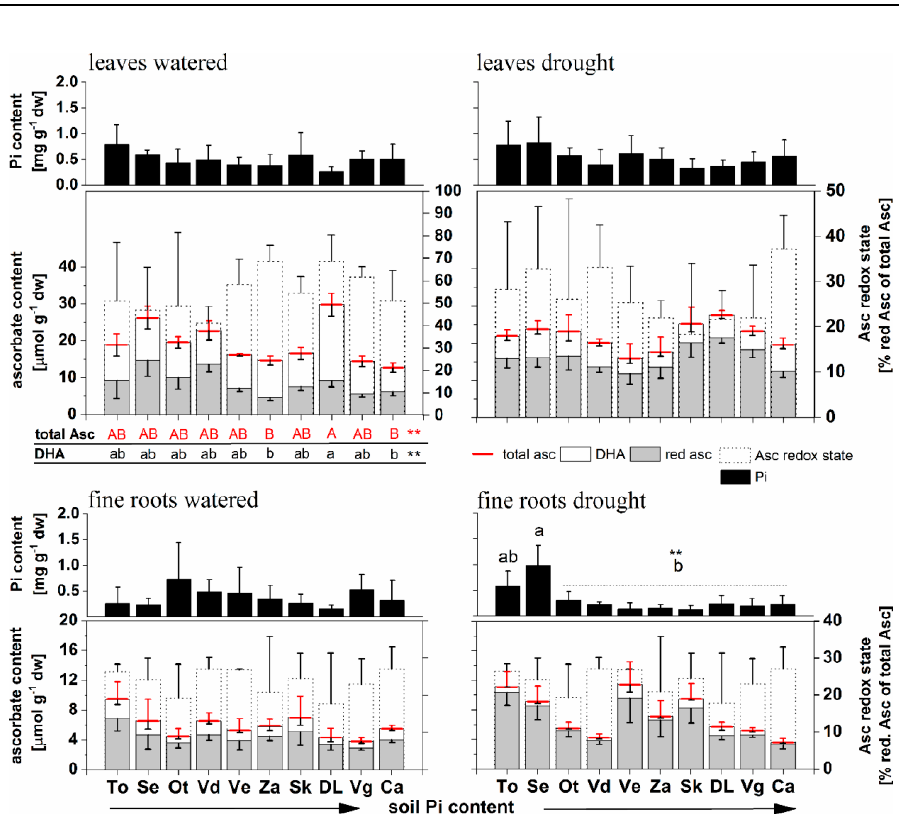
Figure 1. Asc content, its redox state, and Pi contents in leaves and fine roots of well-watered and drought-stressed beech saplings. Beech habitats on the x -axis are ordered according to total Pi availability in the soil (sum of Pi min and Pi org ). The bars show means ± S.D.s of four replicates in the well-watered treatment and five replicates in the drought treatment. Black bars = Pi; grey bars + negative whiskers = red Asc; white bars + negative whiskers = DHA; red line + positive whiskers = total Asc (sum of red Asc and DHA); dashed bars + positive whiskers = Asc redox state. Different capital letters indicate statistically significant differences in foliar total Asc between the ecotypes. Minor letters represent statistically significant differences in foliar DHA between the ecotypes. Ns = not significant. Results were derived from one-way ANOVAs at p < 0.01. Table 5. C, N, δ 13 C, and C/N ratios in leaves and fine roots. Data shown are mean values + S.D.s of four replicates for well-watered saplings and five replicates for drought-stressed saplings. p = re- sults of one-way ANOVAs for the well-watered and drought treatments for the different ecotypes . Different minor letters represent statistically significant differences between ecotypes at p < 0.01 . Beech ecotypes according to decreasing total Pi. Leaves Site